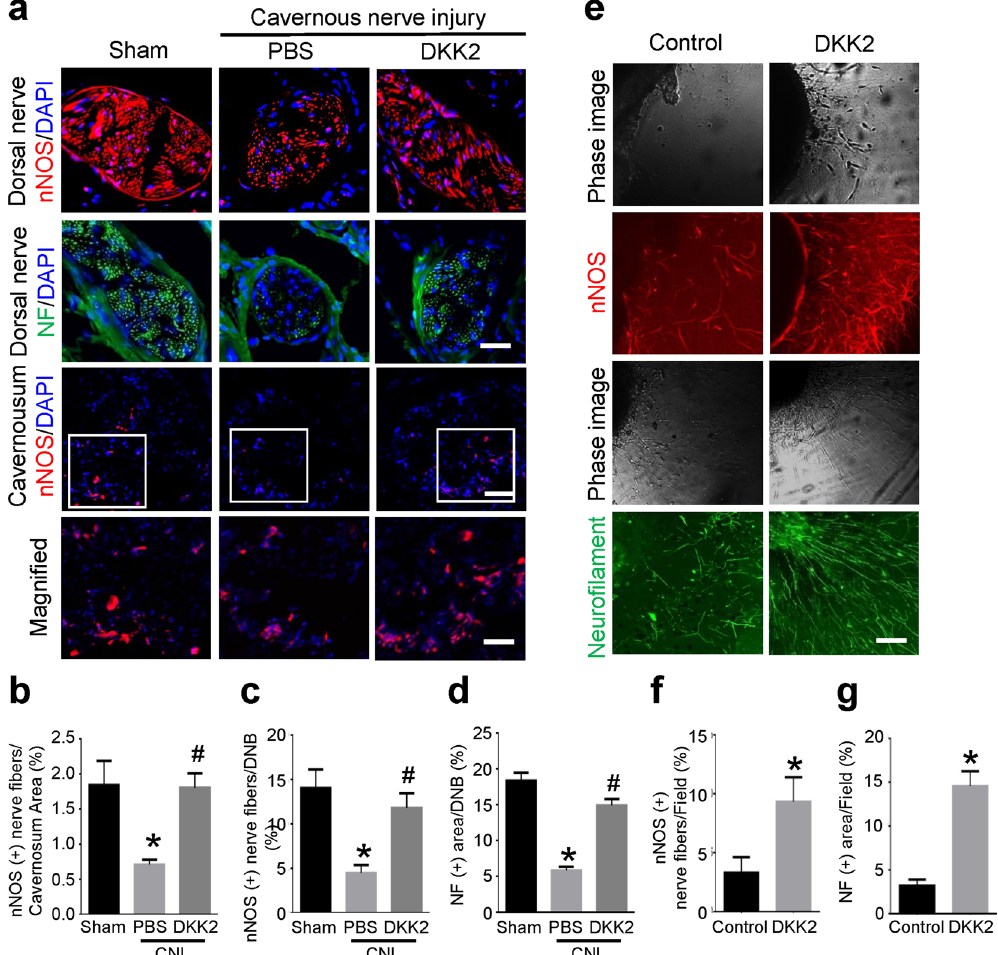
Figure 2. DKK2 induces neural regeneration. (a) nNOS (red) and neurofilament (NF, green) staining of penis tissue from sham operation group or CNI mice 1 week after receiving intracavernous injections of PBS (20 μ l) or DKK2 protein (days -3 and 0; 6 µ g/20 µ l). Nuclei were labeled with DAPI (blue). Scale bar 25 µ m (upper row), 100 µ m (mid row), and 25 µ m (lower row). (b–d) Quantitative analysis of cavernous nNOS- and neurofilament- immunopositive area in cavernous tissue or dorsal nerve bundle (DNB) was performed by an image analyzer. Each bar depicts the mean ( ± SE) values from n = 6 animals per group. * P < 0.05 vs. sham operation group, # P < 0.05 vs. PBS-treated CNI group. (e) Neurofilament (green) and nNOS (red) staining in mouse major pelvic ganglion (MPG) tissue, which were treated with PBS or DKK2 protein (300 ng/ml). Scale bar = 200 μ m. (f , g) Quantitative analysis of neurofilament- or nNOS-immunopositive neurite length was performed by an image analyzer. Each bar depicts the mean ( ± SE) values from n = 4 independent experiments. * P < 0.001 vs. control group. CNI = cavernous nerve injury; DKK2 = dickkopf2; nNOS, neuronal nitric oxide